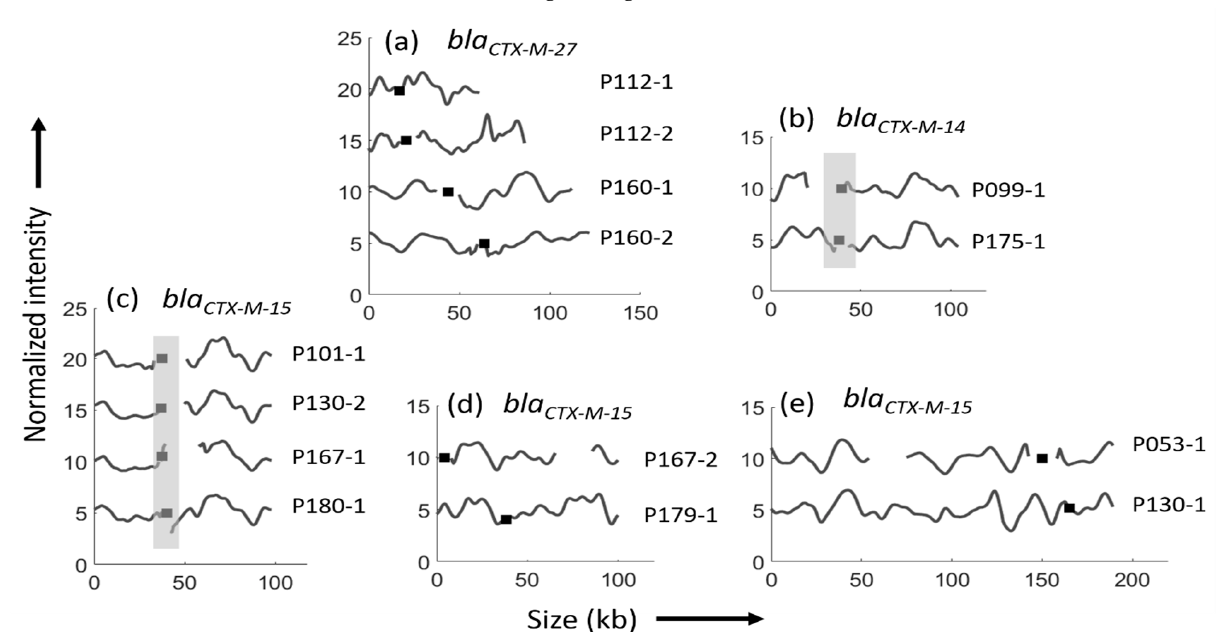
Figure 3. ODM barcodes and bla CTX-M gene location of plasmids from different isolates and patients grouped by the specific bla CTX-M gene. ( a ) Four completely different plasmids encoding the bla CTX-M-27 gene. ( b ) Similar plasmids of different length encoding the bla CTX-M-14 gene. ( c ) Highly similar plasmids, approximately 90 kb in length, encoding the bla CTX-M-15 gene at same gene location, obtained from four different isolates and patients. ( d ) Plasmids encoding the bla CTX-M-15 gene from two isolates with similarity in barcodes, but with different gene locations and different lengths (73 kb and 100 kb, respectively). ( e ) Plasmids encoding the bla CTX-M-15 gene from two isolates showing partial similarity in barcodes, but with different gene locations and different lengths (159 kb and 189 kb, respectively). Black squares indicate the location of the gene and the regions shaded in grey indicates that the gene is in the same location.